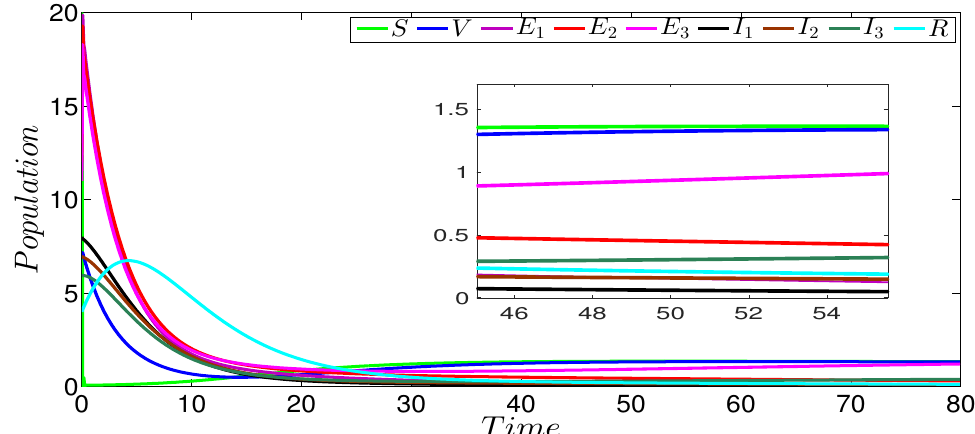
Figure 6. Stability the total endemic equilibrium E t of the three-strain SVEIR model with R 1 = R 2 = 1.93, and R 3 0 0